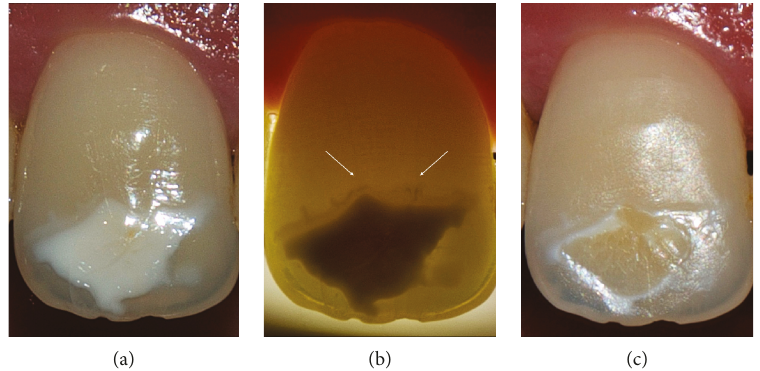
Figure 1: Stained enamel opacity related to traumatic dental injuries (a). The underestimation of the presence of stain into the lesion have led to unaesthetic outcomes after performing resin in fi ltration (c). Note the presence of enamel cracks (white arrow), observed under transillumination, which could constitute a possible pathway for chromatogenic substances (b). This case is considered a